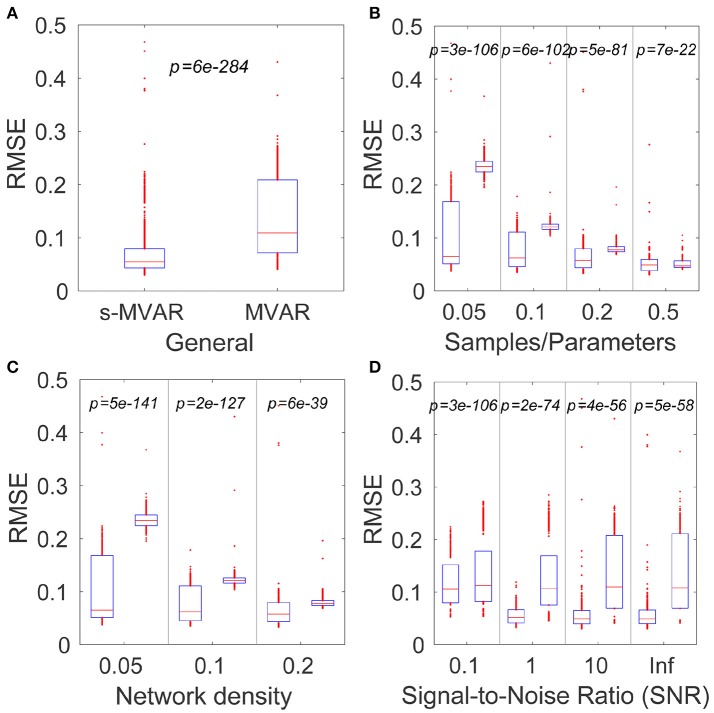
Comparing accuracies of network estimation of the MVAR and s-MVAR modeling approaches. (A) Box plot of estimation accuracies (RMSE) with s-MVAR (left) and MVAR (right) approaches across all factors studies. The red line indicates the median of the sample, while the lower and upper bounds of the blue rectangle indicate the 25th and 75th percentile levels respectively. Red dots outside blue rectangle indicate sample outliers. p-values are the result of one-tailed sign-tests of the hypotheses that the median of the difference between two samples is zero. Low p-values indicate that the accuracy of the s-MVAR estimation is higher than that of MVAR estimation. (B) Box plots and results of one-tailed paired sign-tests comparing s-MVAR and MVAR at different levels of the samples/parameters ratio. The s-MVAR performs better than the MVAR at all levels, especially when the ratio of samples/parameters is small. (C) Box plots and results of one-tailed paired sign-tests, comparing s-MVAR and MVAR at different levels of network density. s-MVAR performs better than MVAR at all levels, especially when network density is low. (D) Box plots and results of one-tailed paired sign-tests, comparing s-MVAR and MVAR at different levels of signal-to-noise ratio (SNR). s-MVAR performs better than MVAR at all levels. This difference is highest at high values of SNR, but most reliable at low values of SNR.